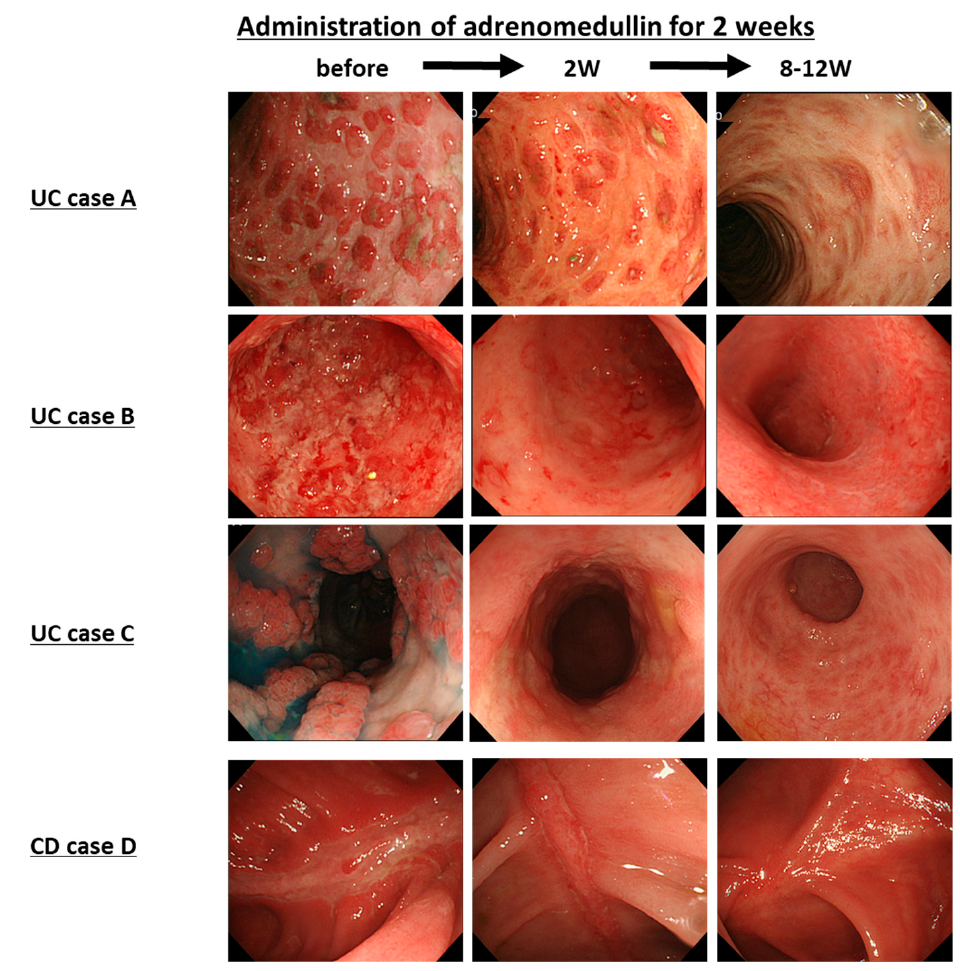
Figure 5. Improvement of colonoscopic findings in adrenomedullin therapy.